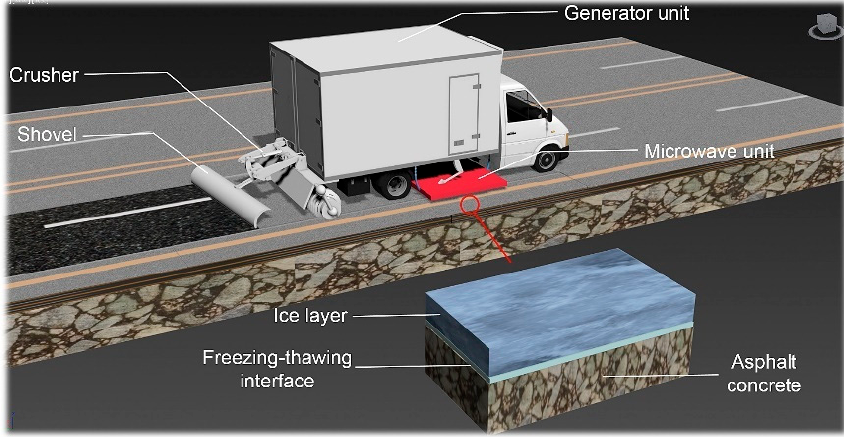
Figure 7. Schematic diagram of de-icing using microwave heating vehicle [86].